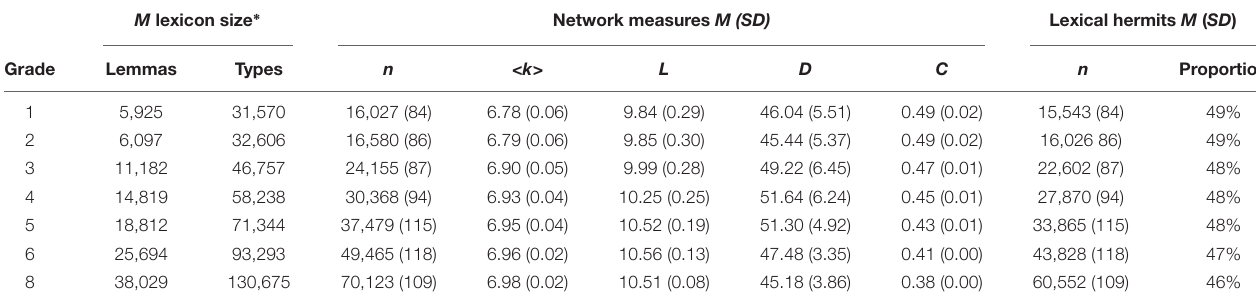
TABLE 1 | Lexicon sizes and network measures in different age